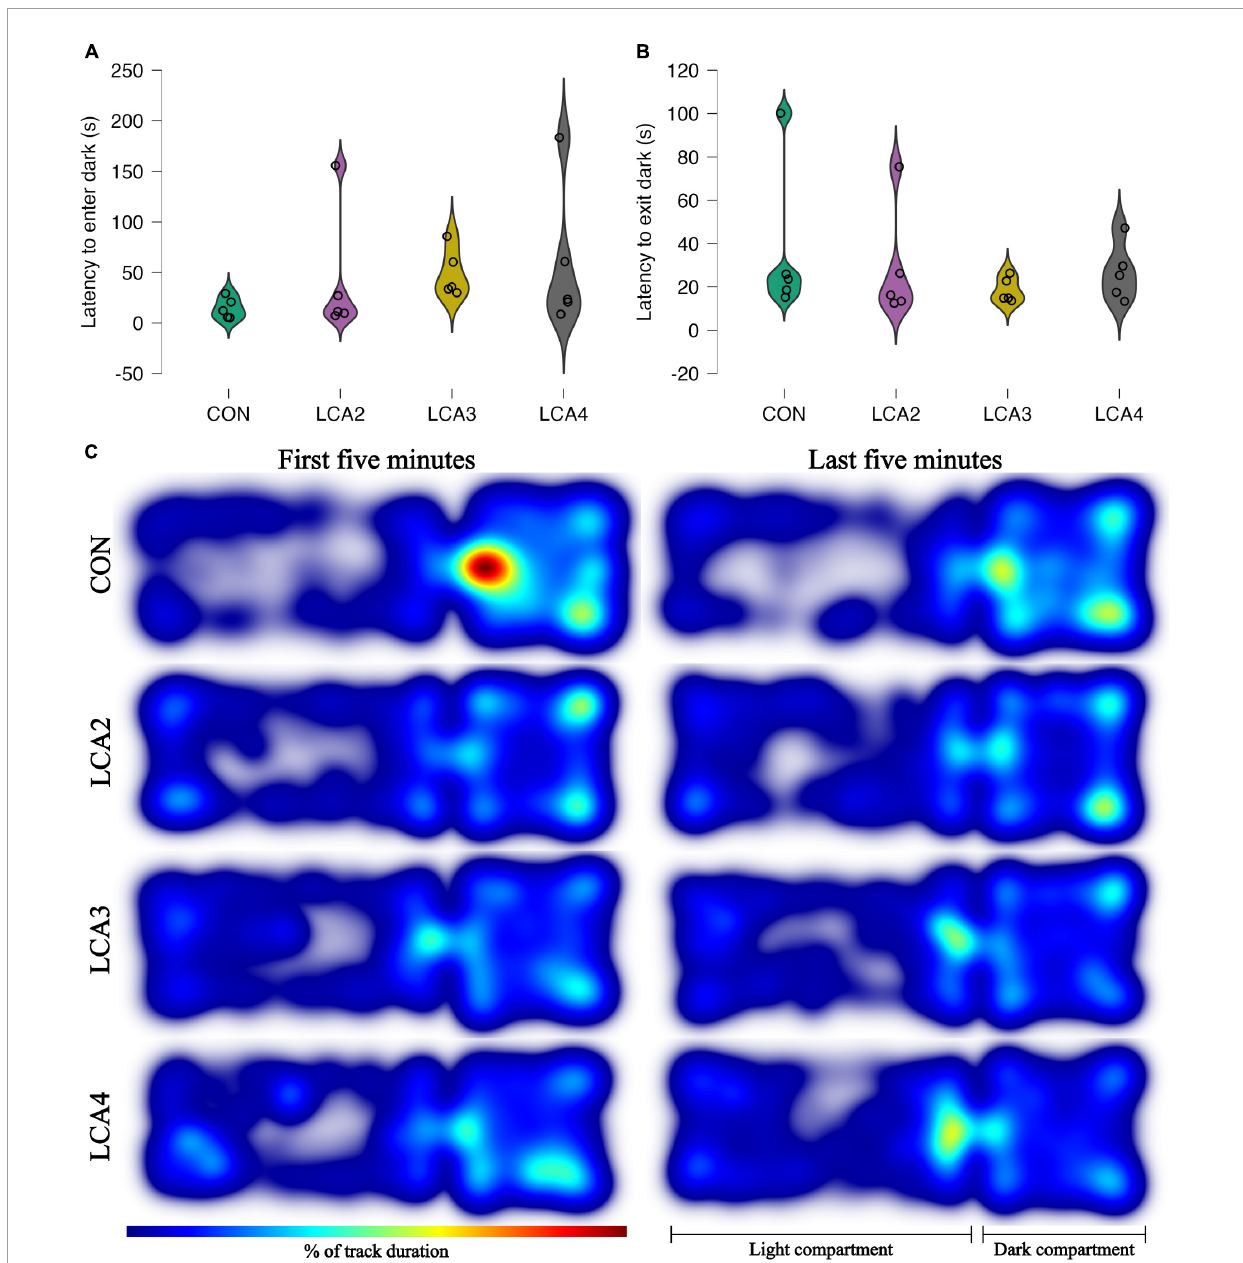
FIGURE4 (A,B) LDB test anxiolytic parameters with individual observations and smoothed distribution curves for each group. (A) The time spent in the light compartment before the first visit to the dark compartment. Group means: CON = 15 s [95% CI (6, 24)], LCA2 = 42 s [95% CI (–14, 98)], LCA3 = 49 s [95% CI (28, 70)], LCA4 = 59 s [95% CI (–4, 123)]. (B) The time spent in the dark compartment before the first transition to the light compartment. CON = 37 s [95% CI (5, 68)], LCA2 = 29 s [95% CI (5, 52)], LCA3 = 19 s [95% CI (13, 24)], LCA4 = 27 s [95% CI (15, 38)]. (C) The heatmaps of each animal merged within groups and time intervals. The color intensity of the heatmaps is scaled relative to the maximum observed value of 8.5%. The LCA groups cover more of the light compartment, while the CON has all its peaks in the dark compartment. The overall tendency between the groups is similar in both time